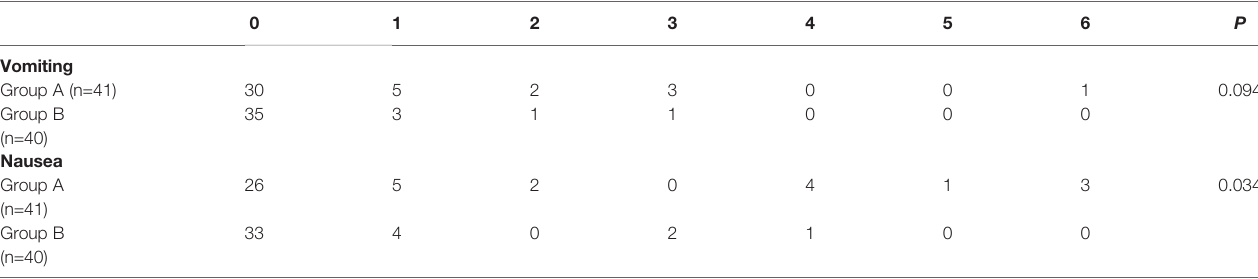
TABLE 3 | The frequency of nausea and vomiting in the whole observation period.